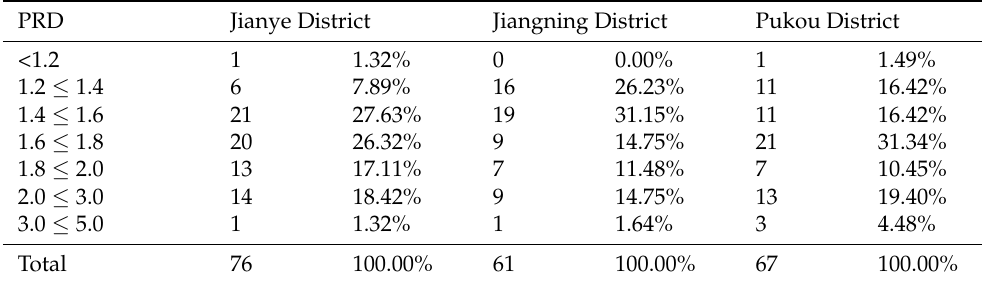
Figure 13. Average PRD of 204 residential areas in Jiangning, Jianye, and Pukou District. Table 8. Number and percentage of residential areas with different levels of PRD .